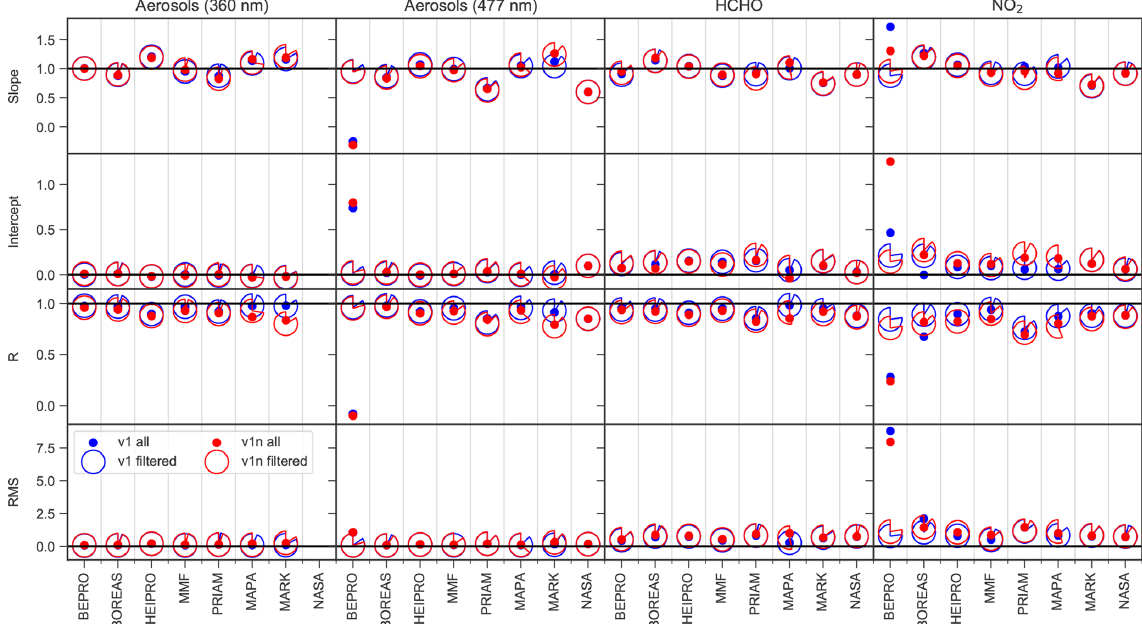
Figure 21. Slope, intercept, regression coefficient, and RMS for the correlation between true and retrieved aerosol extinction as well as HCHO and NO 2 surface concentration. Intercept and RMS values are in dimensionless units for aerosols and 10 11 moleccm − 3 for HCHO and NO 2 . Cloud and fog scenarios (AER8, AER9, AER10) are excluded from the regression